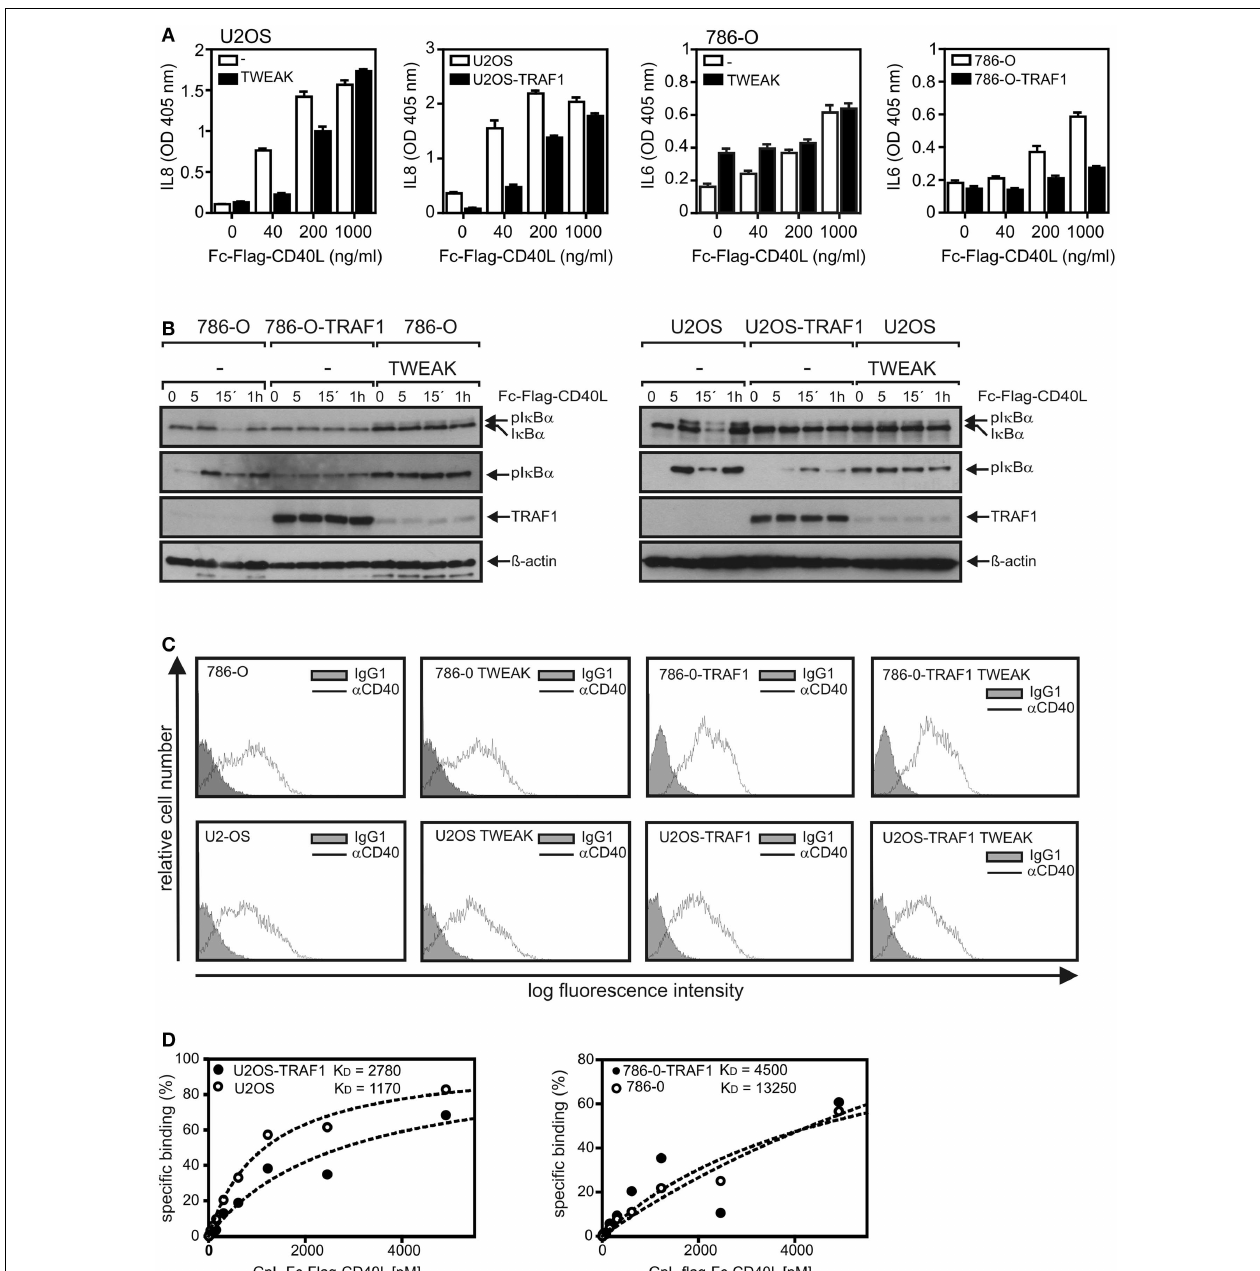
remained untreated and were then analyzed by FACS for CD40 cell surface expression. (D) Cells (2 × 10 5 cells/well) were seeded in 24-well plates. Next day, half of the samples of each cell type were pretreated for 1h at 37°C with 2 µ g/ml of Fc–Flag-CD40L. Next, untreated and Fc–Flag-CD40L pretreated cells were incubated pairwise with increasing concentrations of GpL–Fc–Flag-CD40L (1h, 37°C), a fusion protein of Fc–Flag-CD40L with the luciferase from Gaussia princeps . After removal of unbound CD40L molecules, cells were scratched in 50 µ l medium to measure cell-associated luciferase activity. Specific binding values were obtained by subtraction of the non-specific binding values derived of Fc–Flag-CD40L pretreated cells from the corresponding total binding values. Specific binding values were fitted by non-linear regression using the GraphPad Prism5 software. Specific binding values were normalized according to the maximum binding value obtained from the linear